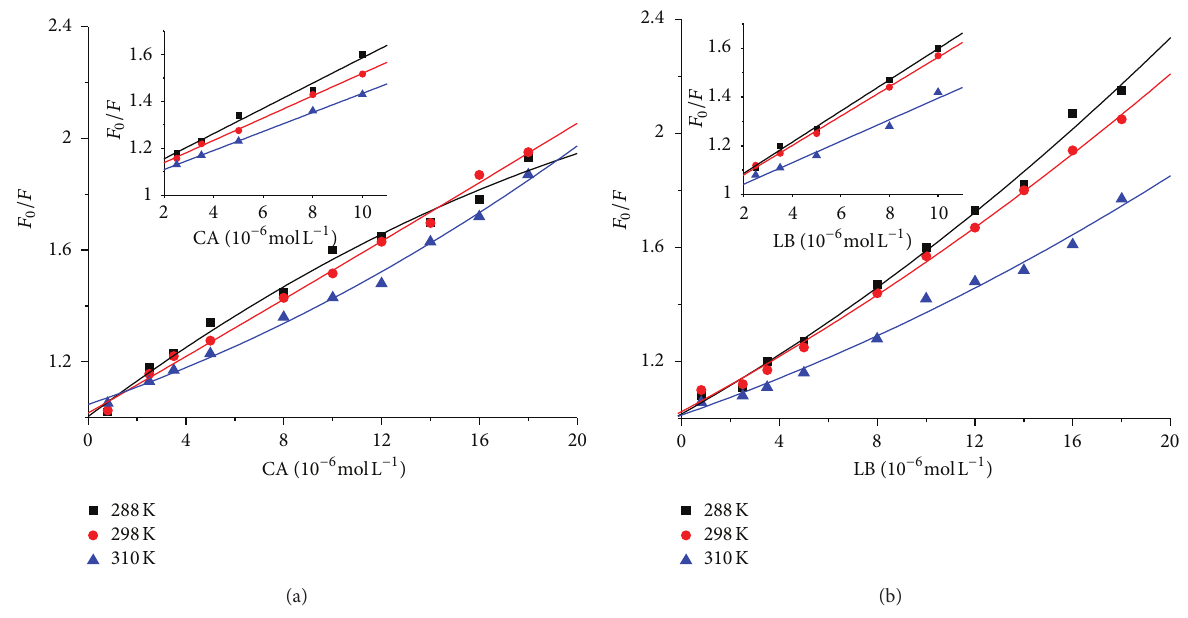
Figure 3: Stern-Volmer plots for the quenching of BSA by CA (a) and LB (b) at different temperatures ( 𝜆 2 × 10 −6 molL −1 .